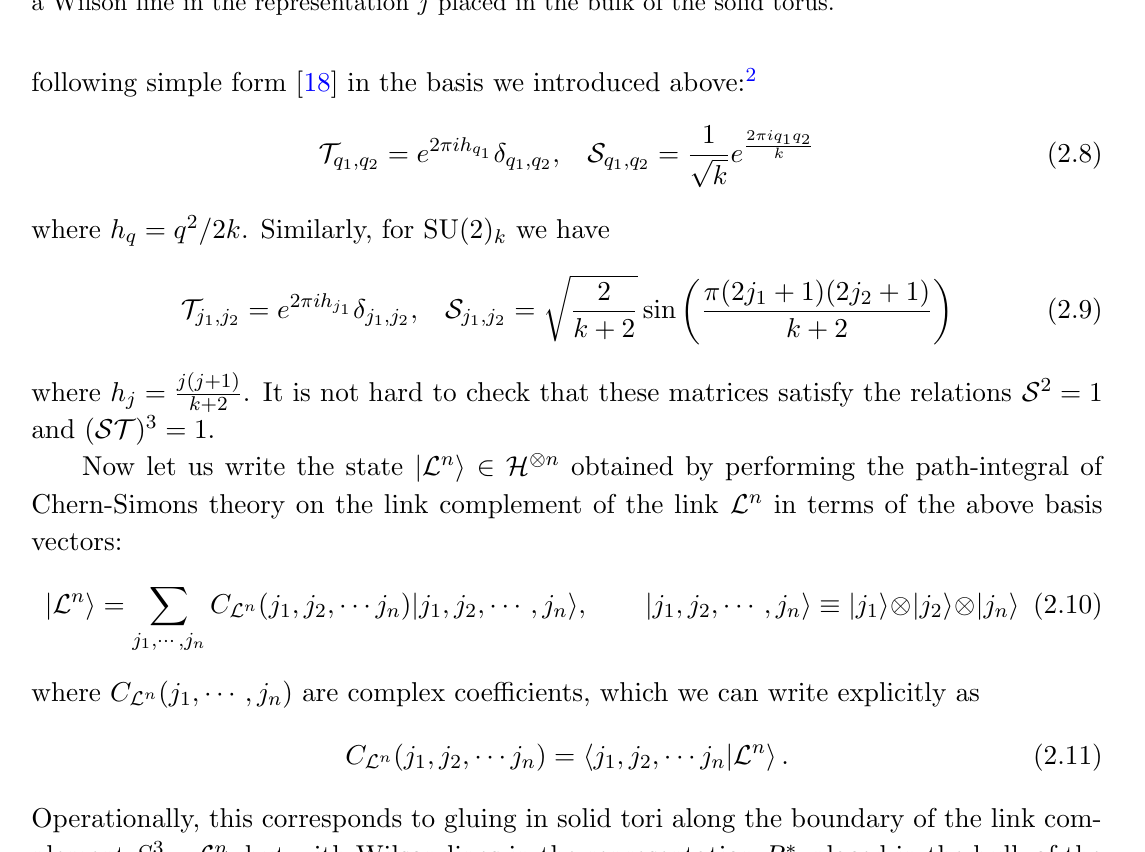
j corresponds to j i